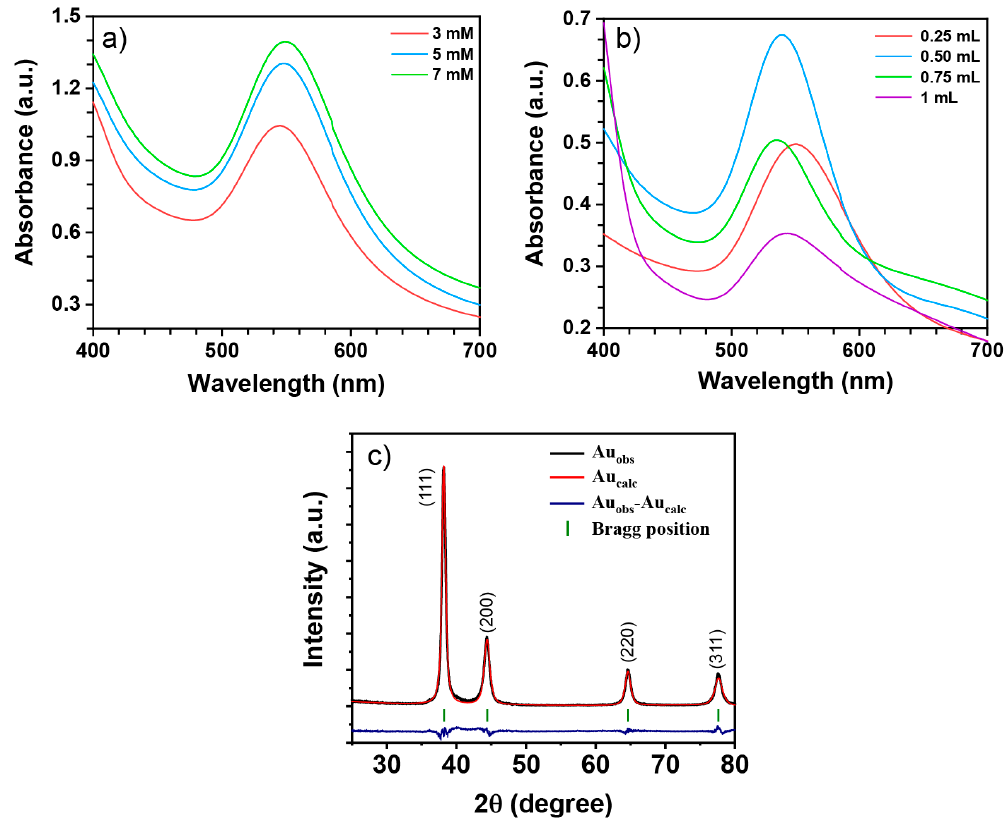
Figure 4. UV-Vis analysis of AuNPs varying ( a ) HAuCl 4 solution concentration and ( b ) Sargassum sp. extract volume, ( c ) Rietveld refinement XRD pattern of Au nanoparticles.